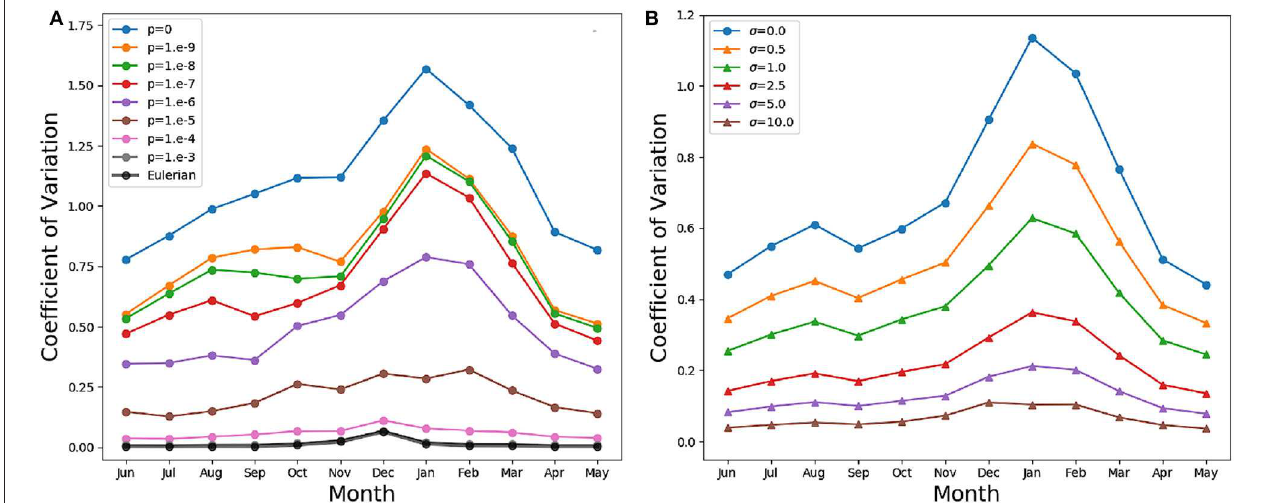
FIGURE 7 | (A) Monthly average coefficient of variation (standard deviation over mean) of the chlorophyll above the turbocline depth in the SAZ simulation. A value of 0 indicates homogeneity, while a value of 1 implies departures from the vertical mean that are as large as the mean itself. The thin lines in color refer to the Lagrangian aquacosms with different values of the coupling parameter p . The thick black line refers to the eddy-diffusive Eulerian simulation. (B) Monthly average coefficient of variation of the Lagrangian simulation with p = 10 − 7 , and the same quantity computed from profiles coarse-grained using a Gaussian kernel estimator with standard deviation σ = 0.5, 1, 2.5, 5, 10 m. The line σ = 0 refers to the results without